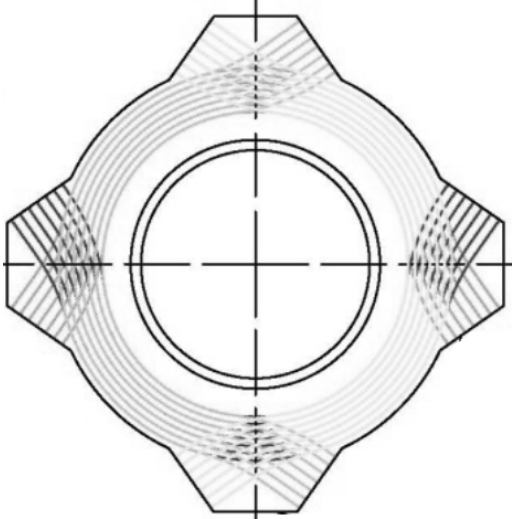
Figure 5. Tendon rings established in the accumulation tank.